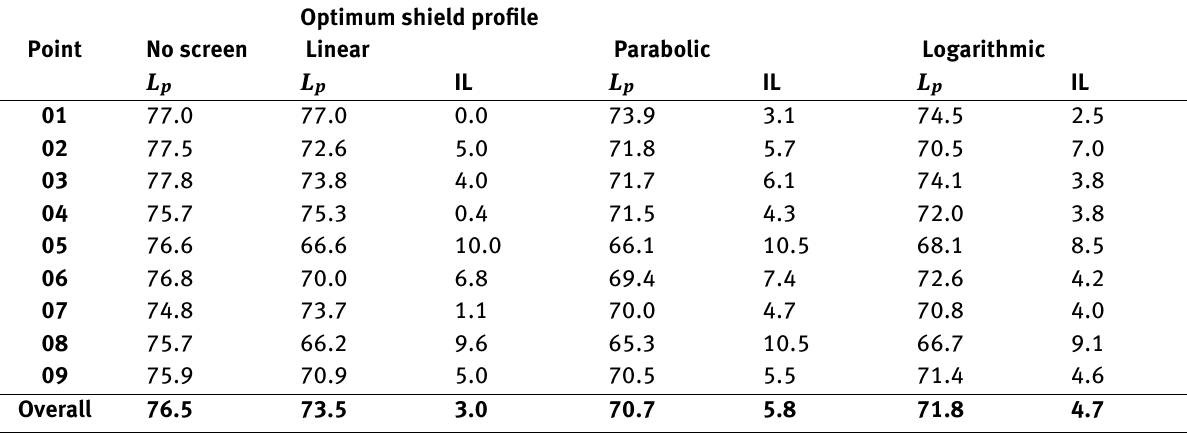
Table 4: Sound pressure level with and without noise screens: Receiver 01. All values in dB(A) Optimum shield profile